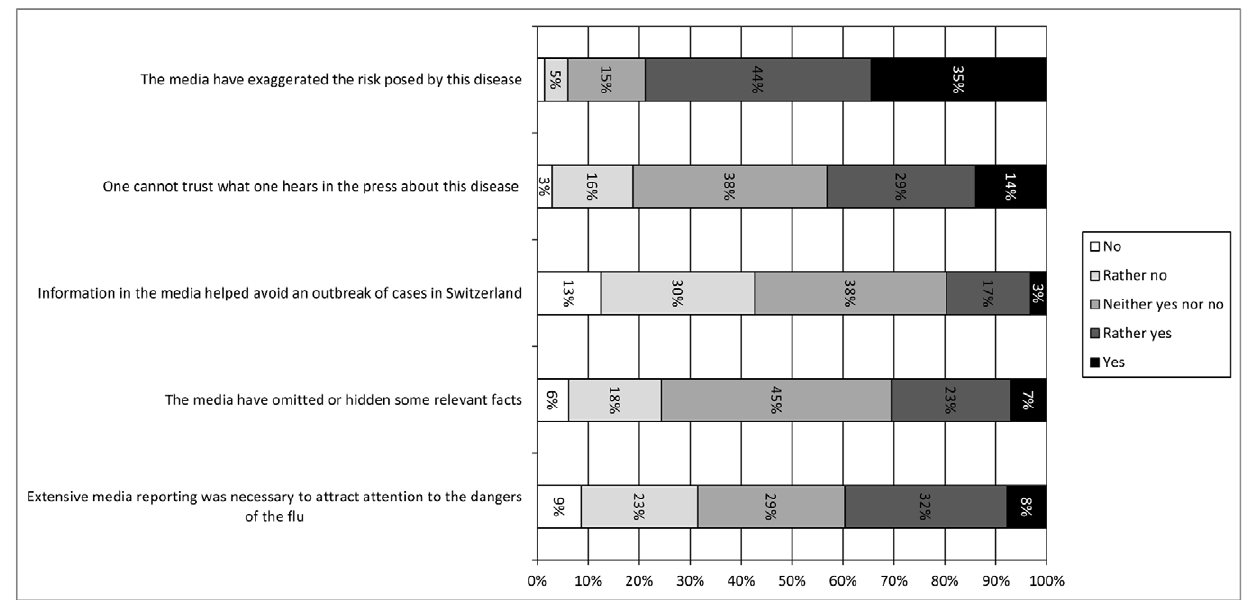
Figure 5. Perceptions of the Role of the Media, Wave 2.